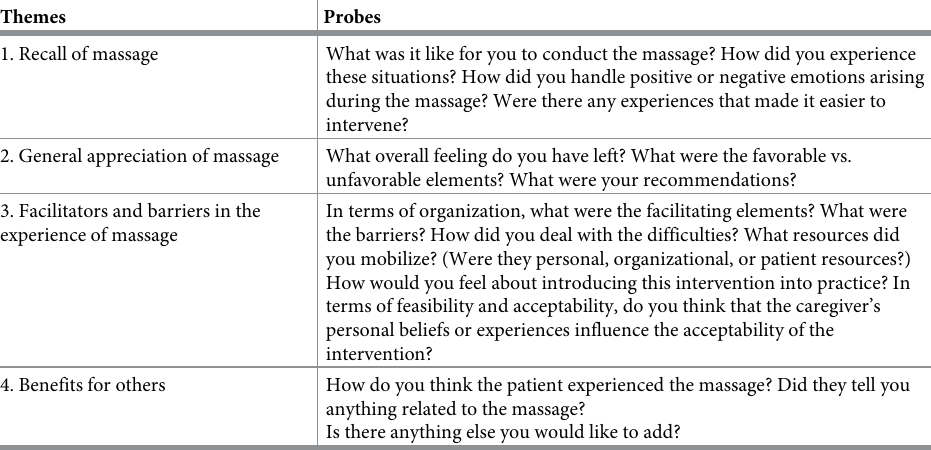
Table 1. Interview guide for the focus